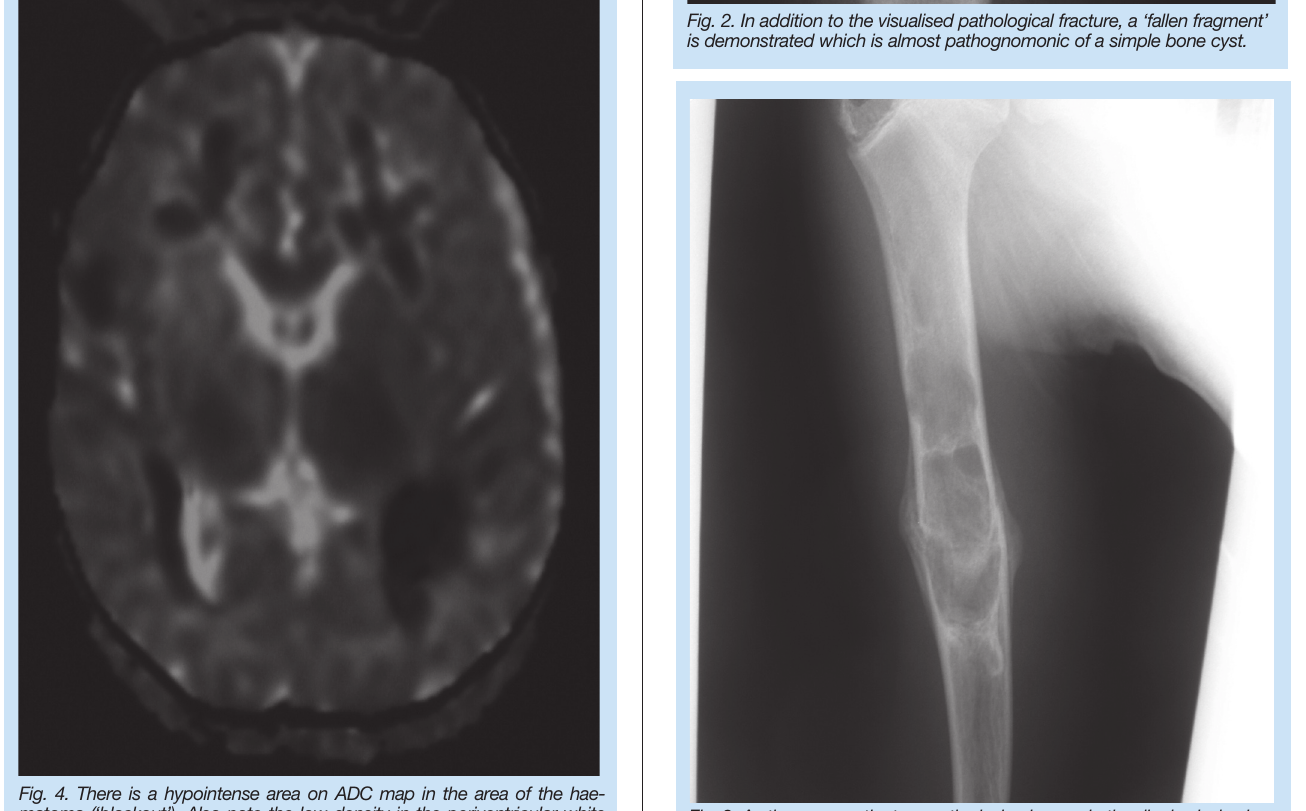
Fig. 3. As the same patient ages, the lesion is seen in the diaphysis, having moved away from the growth plate. This is typical for simple bone